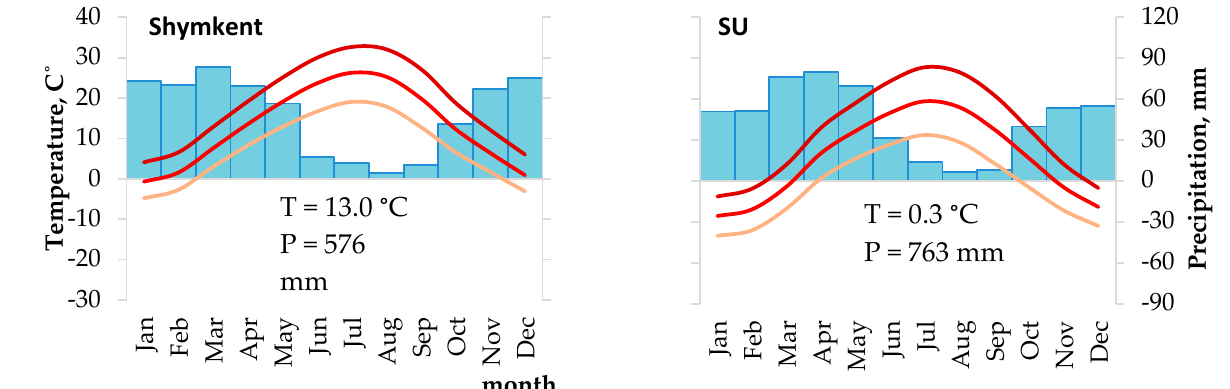
Figure A2. Average monthly climatic characteristics for geographic grid cell where the sampling site Sairam-Ugam (SU) is located (CRU TS 1901–2020), and at the closest meteostation in Shymkent City (42°19 ′ N 69°37 ′ E, 402 m a.s.l.; 1981–2010; http://www.pogodaiklimat.ru/climate/38328.htm; accessed on 10 April 2023) on plains to the west of that area. Lines represent maximum (dark), mean (medium), and minimum (light) temperatures; bars represent precipitation. Note that despite severe differences in the mean values of both temperatures and precipitation, their seasonal curves are remarkably similar between plains and mountains. Since the sampling site is located in the foothills on the western side of the grid cell, we should expect the mean values of temperature and precipitation to be in between the two presented diagrams.